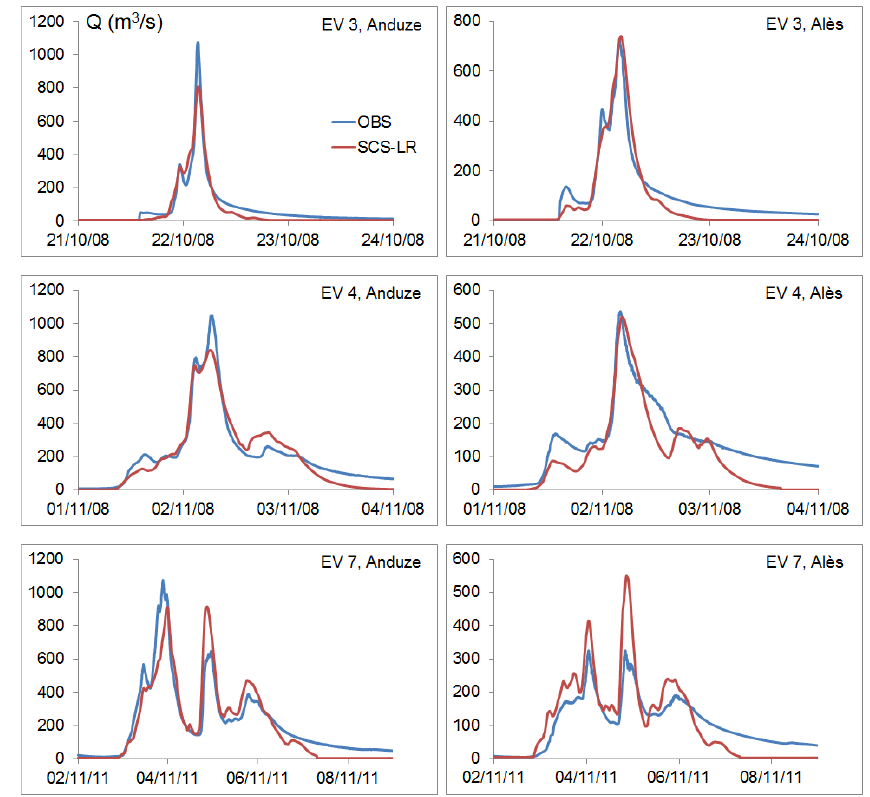
Figure 4. Hydrographs modelled with SCS–LR for event nos. 3, 4, and 7 at the Anduze and Alès stations.